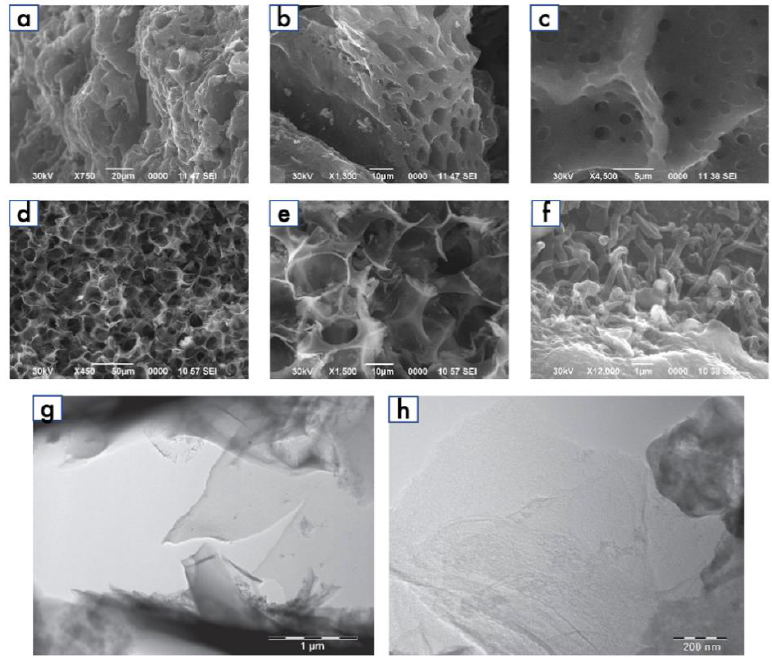
Figure 3. Electron microphotographs of WS-derived carbons: ( a – c ) SEM images before thermo- chemical activation; ( d – f ) SEM and ( g , h ) TEM images after thermo-chemical activation .